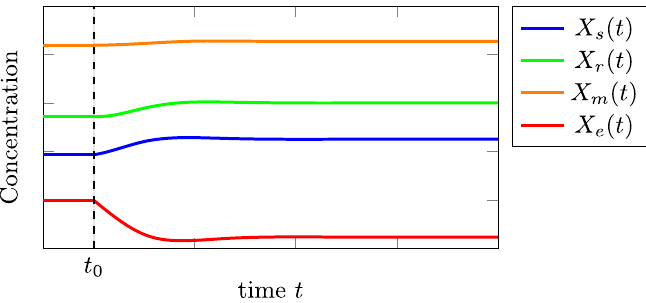
Figure 8: Simulation of the response of the concentrations of active RAS, RAF, MEK, and ERK after inhibition of the activity of MEK. The system starts out in equilibrium with k 1.0 me = . The concentrations of RAS, RAF, MEK, and ERK are recorded after the parameter controlling MEK activity is decreased to k 0.98 me = from t t 0 =